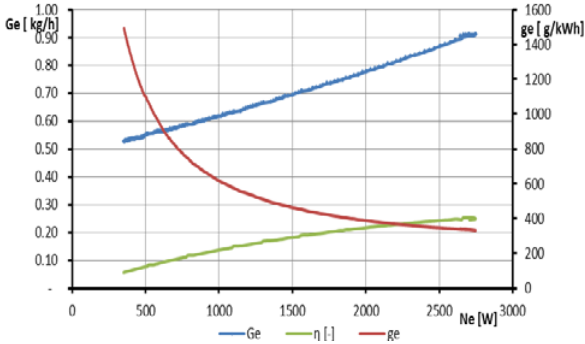
Fig. 9. Load characteristic of power